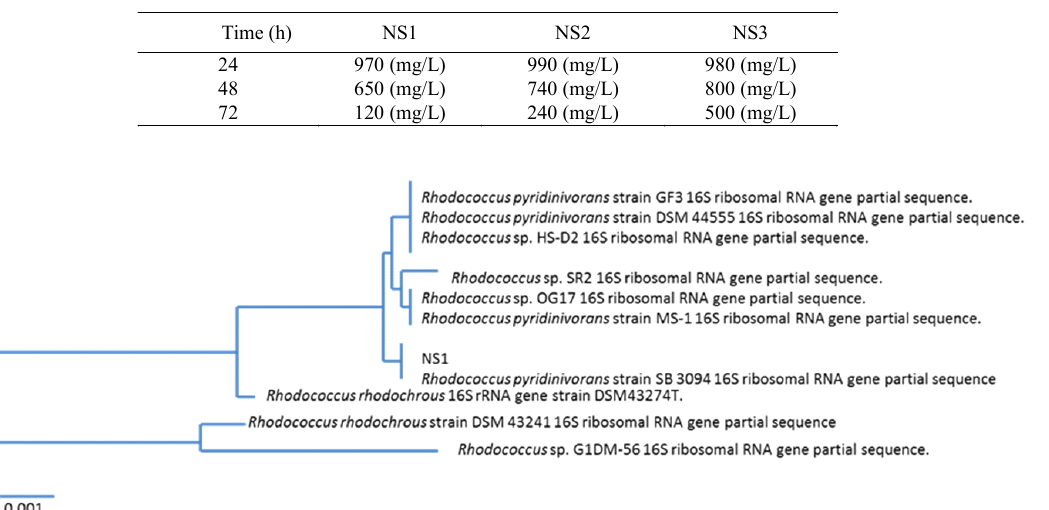
Table 2. Concentrations of residual phenol during 3 days experiment with the inoculation of isolated strains